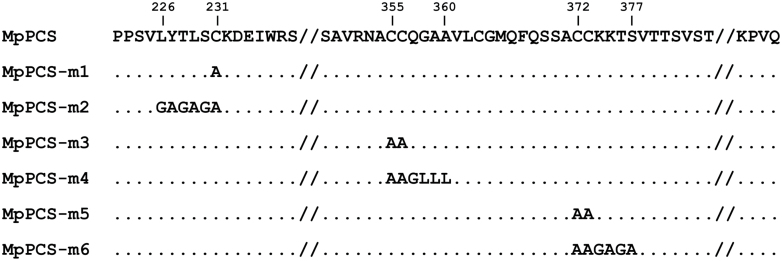
Scheme of C-terminal mutations in MpPCS proteins. The numbers above the wild-type sequence indicate the first and last positions of mutated amino acids, a dot indicates any amino acid identical to that of wild-type MpPCS, and the symbol ‘//’ marks the omission of a partial amino acid sequence due to space limitations.